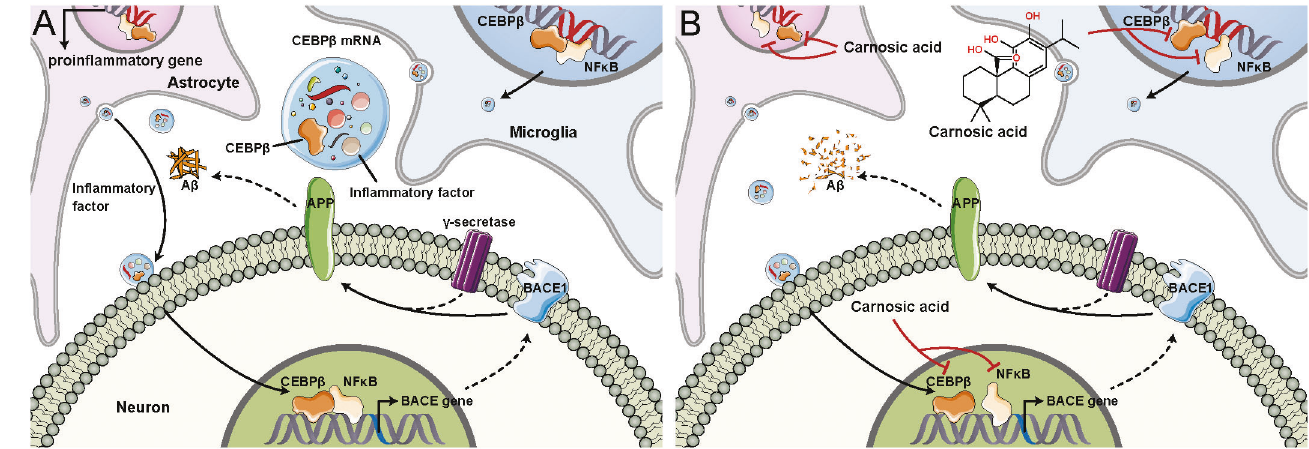
Fig. 9 Schematic diagram of CA on the regulation of CEBP β – NF κ B interaction in the AD brain. A The increases of CEBP β – NF κ B interaction enhance NF κ B DNA binding activity, facilitating the transcription of NF κ B target genes. The upregulation of CEBP β and NF κ B downstream genes, proin fl ammatory cytokines, could increase the releases of in fl ammatory factor from the microbubbles or exosomes secreted by microglia or astrocytes. NF κ B-mediated increases and activation of BACE1 prompt the amyloidogenic processing of APP, followed by the γ -secretase cleavage, leading to the A β production by the neuron. Chronic in fl ammatory conditions and A β depositions exacerbate the binding of CEBP β -NF κ B, deteriorating the AD-like pathology. B CA provides neuroprotective effects by preventing the nucleus translocation of NF κ B, reducing the expressions of proin fl ammatory cytokines. Meanwhile, CA reduces the CEBP β – NF κ B interaction and alleviates A β aggregation via inhibiting the amyloidogenic proteolytic pathway of